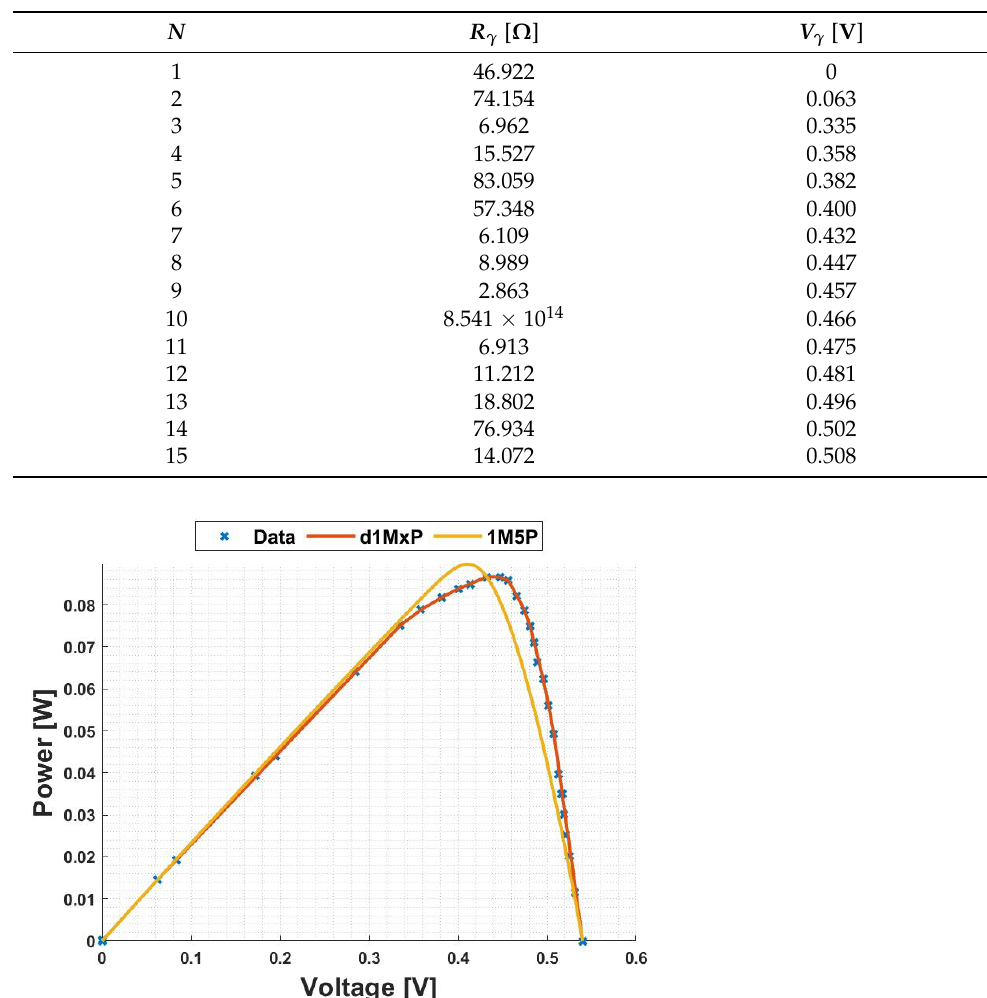
Table 2. Quantitative values computed for the branches connected in parallel, for T = 40 ◦ C.